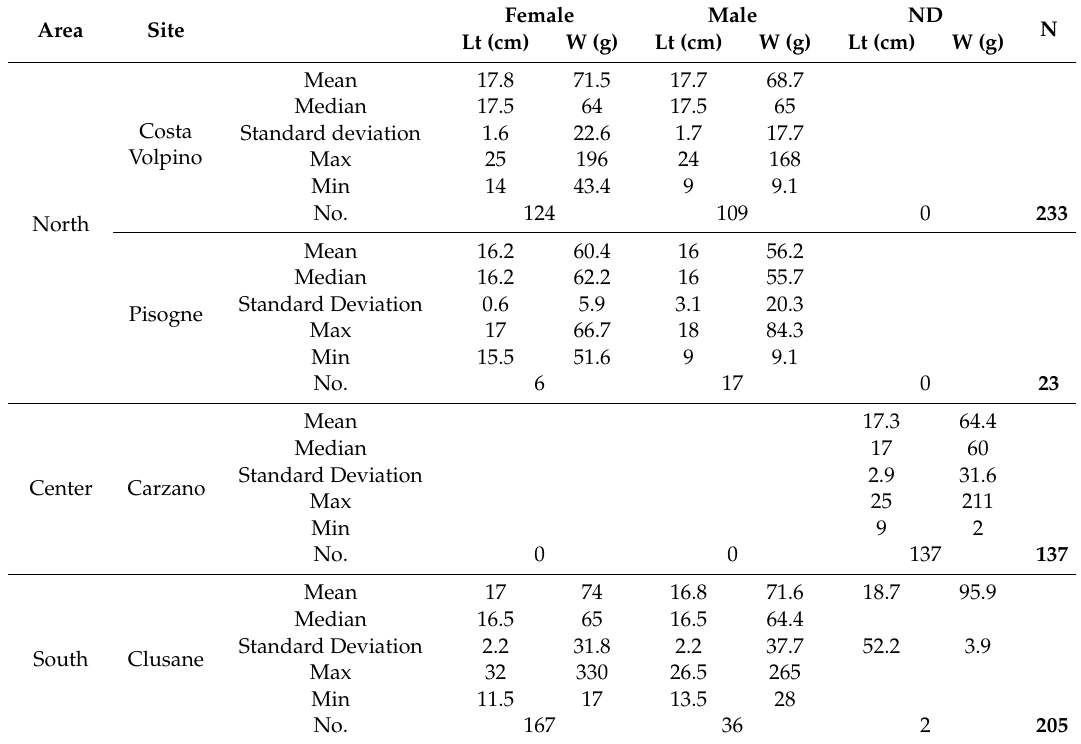
Table 1. Area, sampling site, total length (Lt), total weight (W), and sex of fish (N) sampled in Lake Iseo (ND = sex not determined).